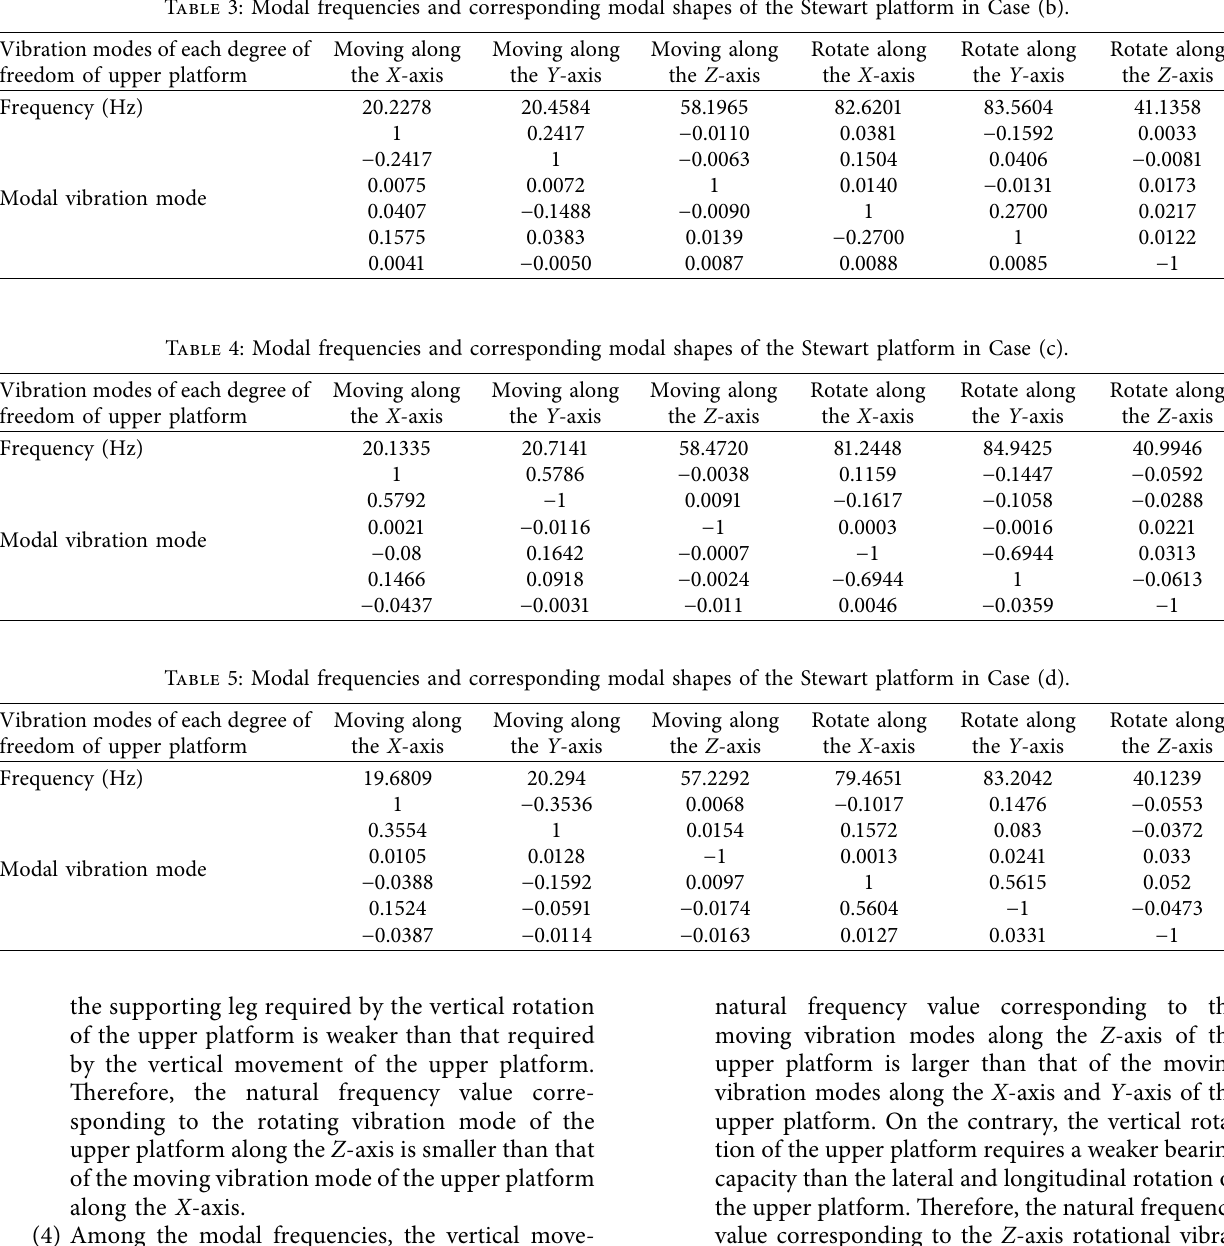
Table 3: Modal frequencies and corresponding modal shapes of the Stewart platform in Case (b). Vibration modes of each degree of freedom of upper platform